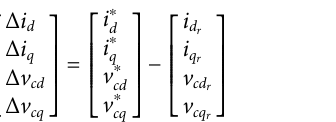
Figure 7 . Rated parameters of the HESS including output current and SC cluster voltage reference in normal condition are given in Mode I, where i dr and i qr represent the rated active and reactive current, while v cdr and v cqr represent rated d- and q- axis of SC cluster voltage. The variations between the rated parameters and the reference parameters of Mode II are subsequently expressed as follows: